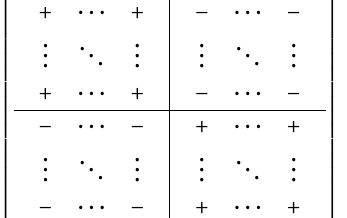
of two of the positive edges in one K other weights to be ±1 and consistent with the signs of the edges of G .